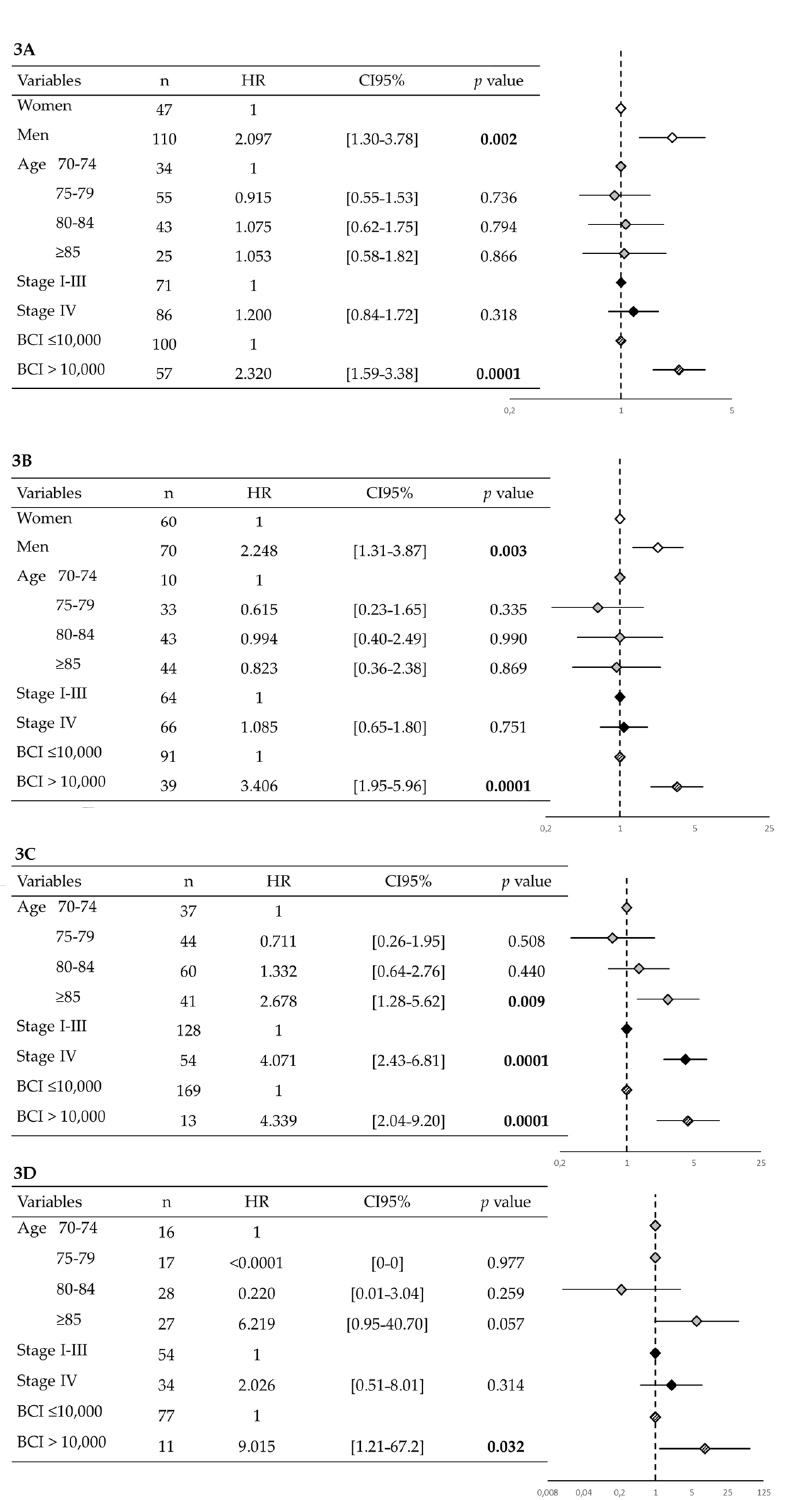
Figure 3. Multivariate COX Analysis in the four prominent sites of our population: thoracic (panel 3 A ), gastro-intestinal (panel 3 B ), prostate (panel 3 C ) and breast (panel 3 D ). Gender was excluded from the Cox analysis of prostate (only males) and breast (too few male to perform analysis n = 3). Significant p -values were highlighted in